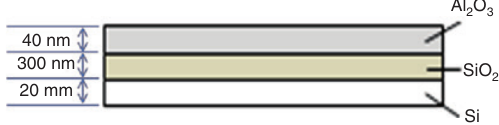
Figure 1: Dimensions and structure of the